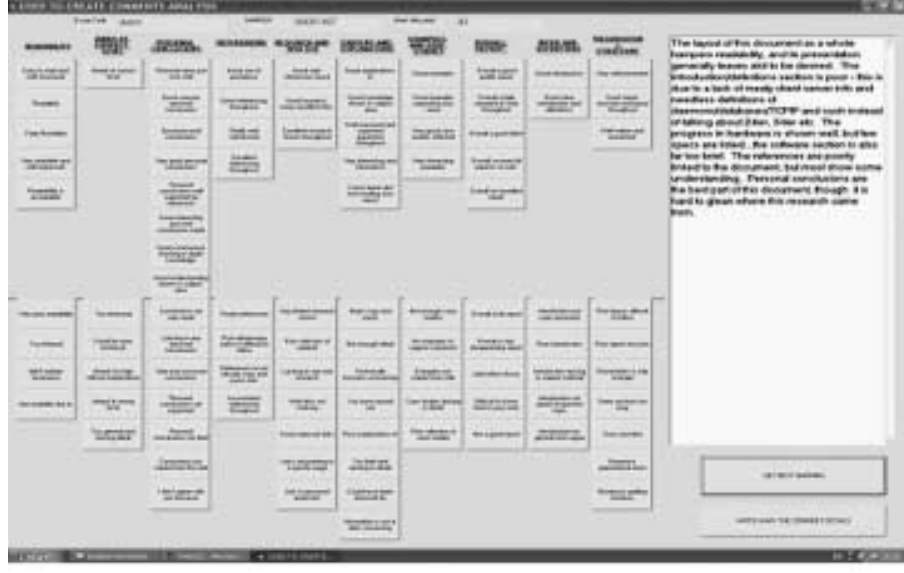
Figure 2. Mark-up tool for quantifying comments